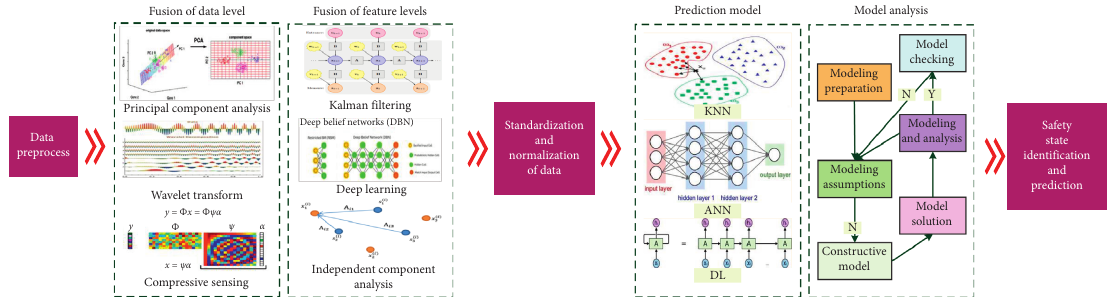
Figure 8: Data fusion technology for multisource collaborative monitoring.